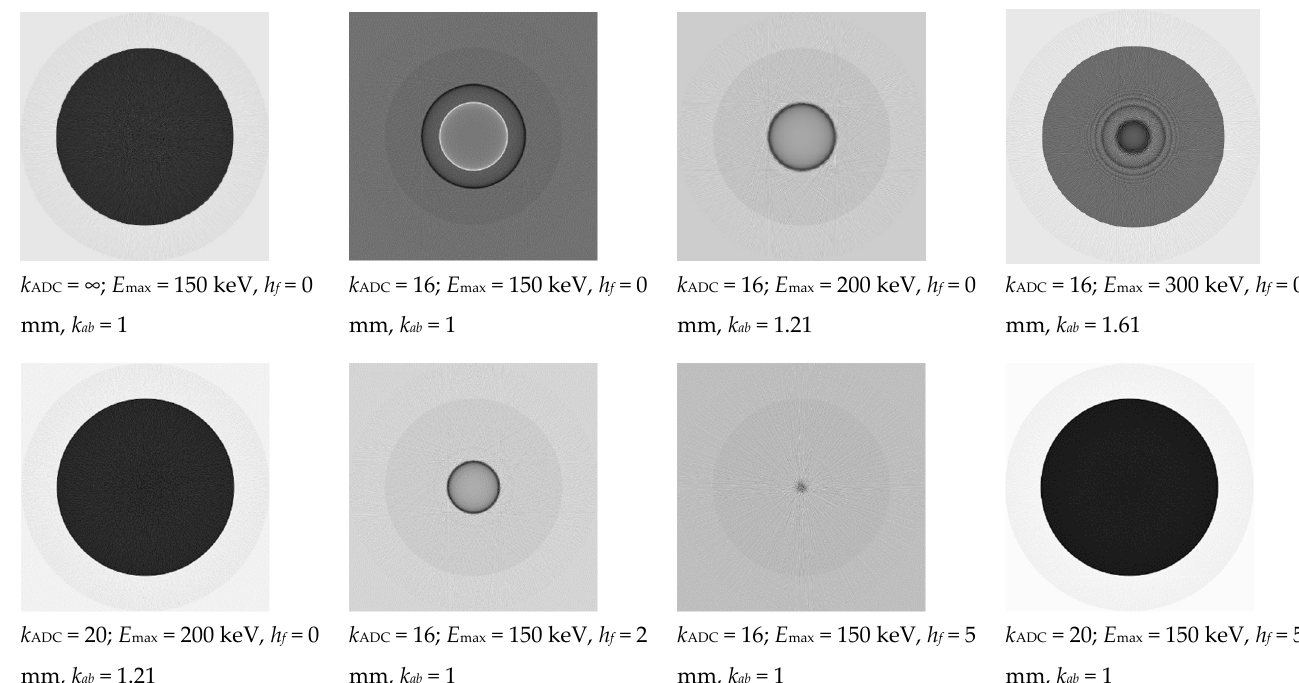
Figure 2. Reconstructed slices of an aluminum cylinder with a diameter of 250 mm.